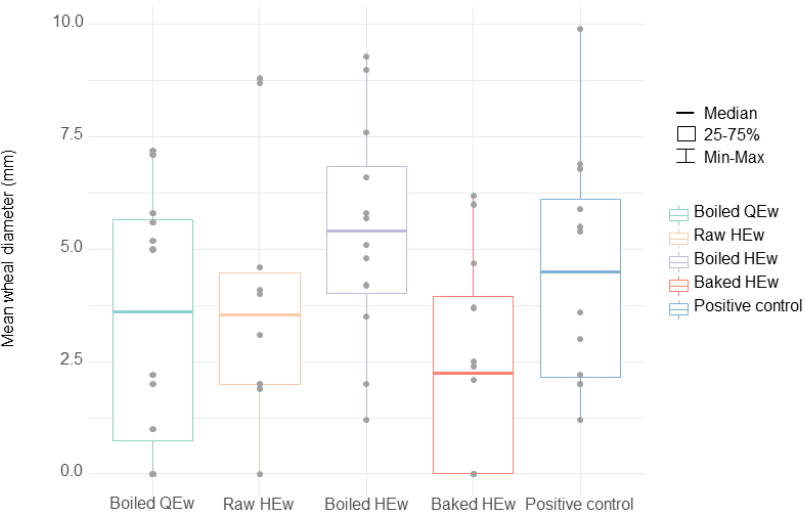
Figure 3. Boxplot showing the distribution of the results of the skin prick tests (mm, mean wheal diameter) for boiled quail egg white, raw hen’s egg white, boiled hen’s egg white, and stone-baked hen’s egg white extracts. The boxes show the interquartile ranges with the median value as the midline ( p = 0.113). QEw, quail egg white; HEw, hen’s egg white.